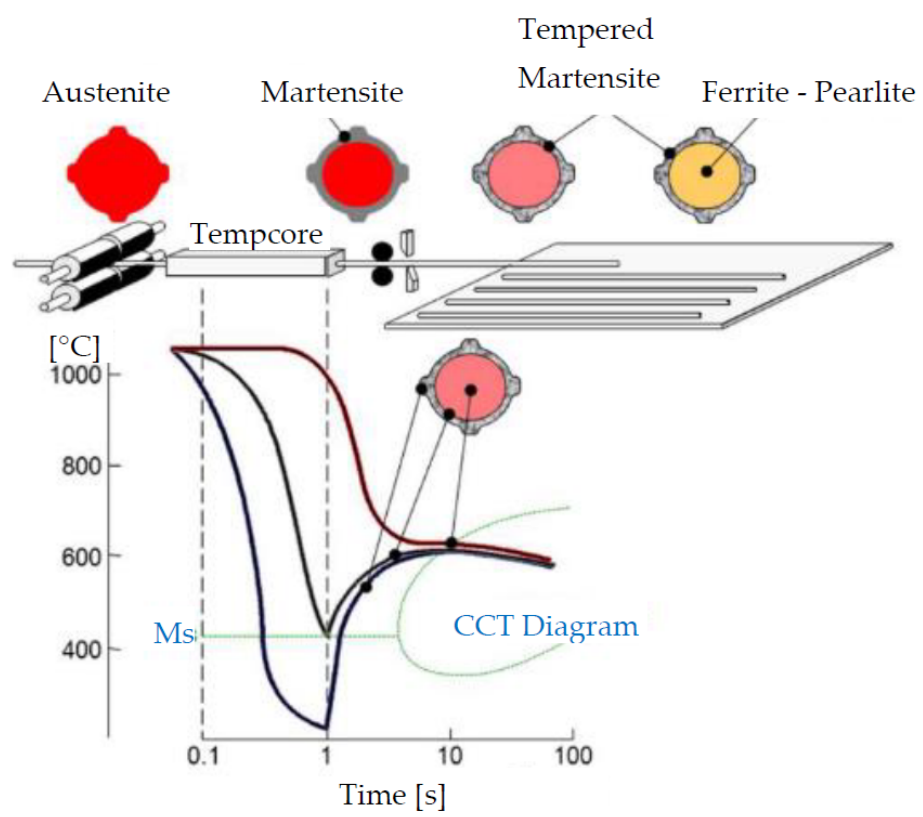
Figure 1. The principle of the Tempcore process. Within the former Czechoslovakia, in the 1990s, Tˇrineck é želez á rny Ltd. produced hot- rolled reinforcement with controlled cooling from the post-rolling temperature (thermally refined reinforcement) with the designation 10 505.9 (R). Today it is a reinforcement with the designation B500 B according to codes STN EN 1992-1-1 [8] and STN EN 10080 [24]—this designation will be used further in the